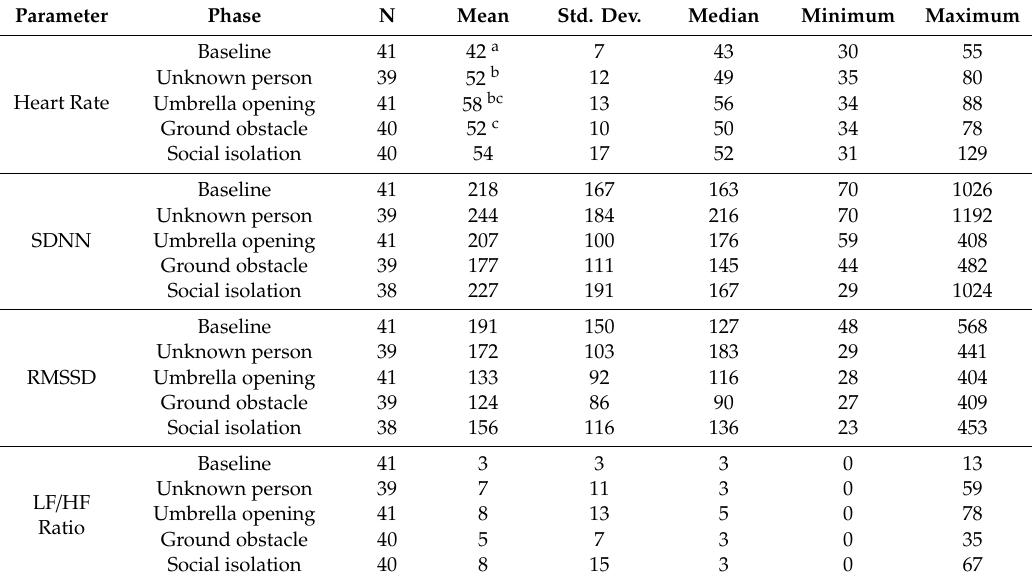
Table 4. Physiological data results of experiment